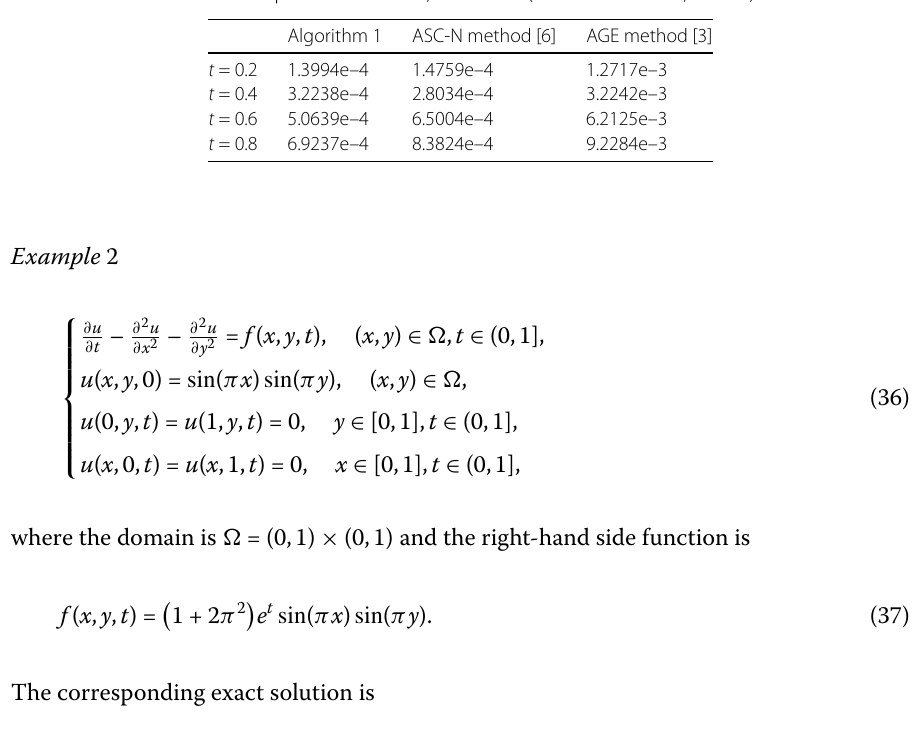
Table 6 Maximum error comparison for r = 15, h = 1/121 ( m – 1 = 120 = 6 K , K =